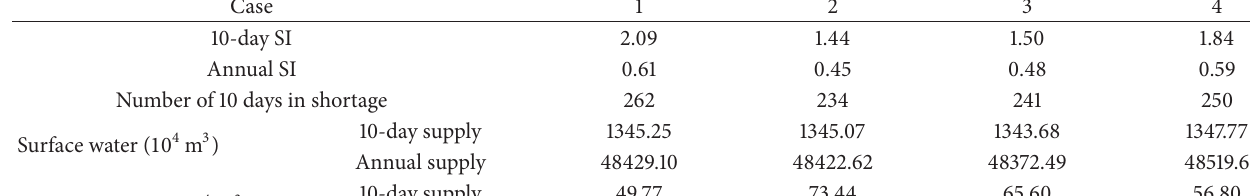
Table 4: The shortage indices and the supply of water system in the cases.